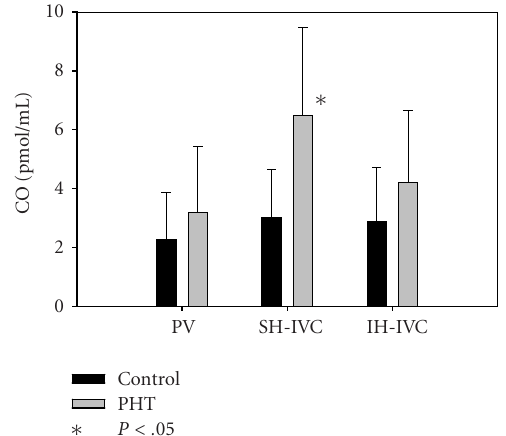
Figure 4. Nitric oxide (NO) in portal vein (PV), suprahepatic inferior vena cava (SH-IVC), and infrahepatic inferior vena cava (IH-IVC) in control rats (Group I) and in rats with triple stenos- ing ligation of portal vein (TSLP) (Group IIb) after 28 days of evolution.